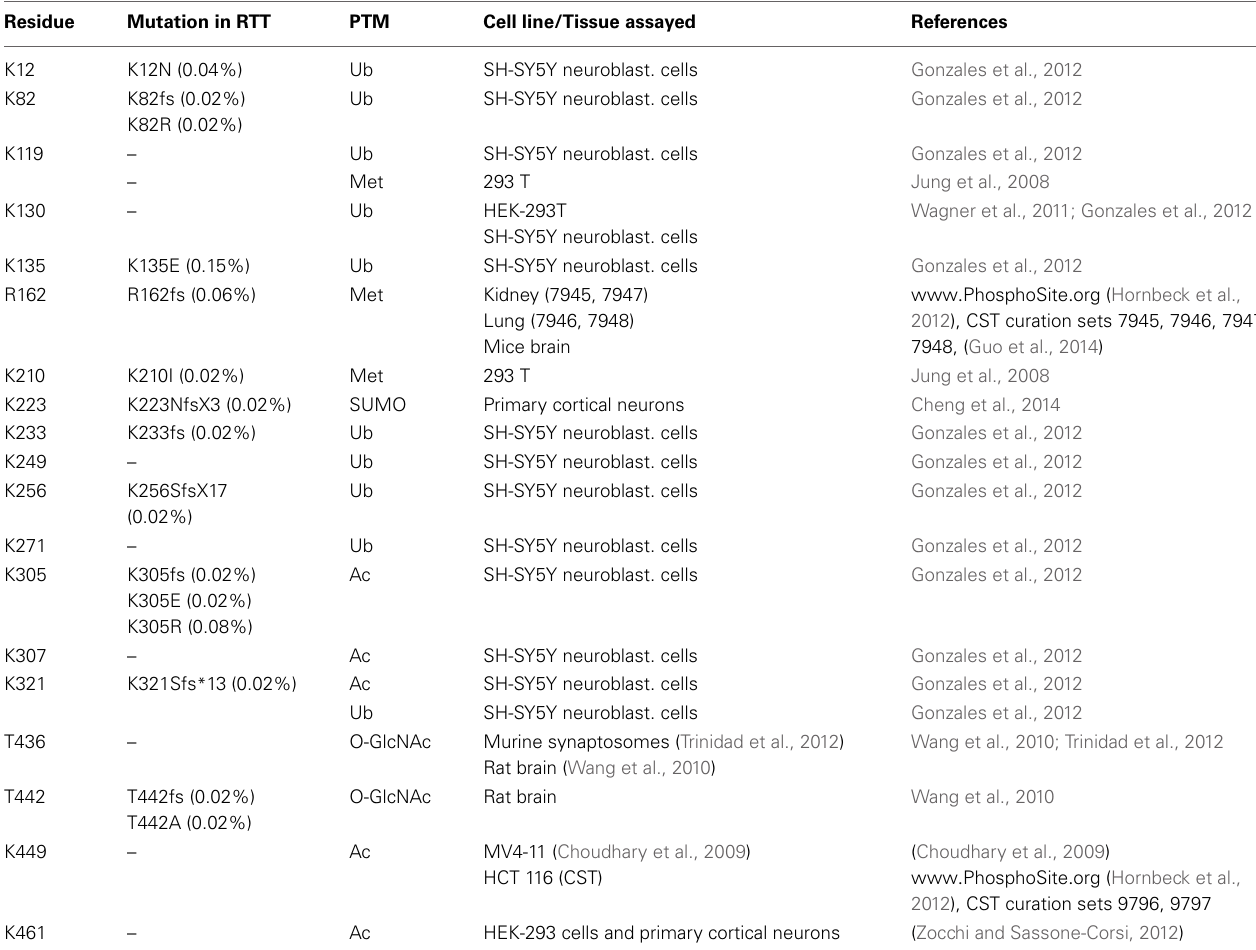
Table 2 | Post-translational modifications within MeCP2 other than phosphorylation.